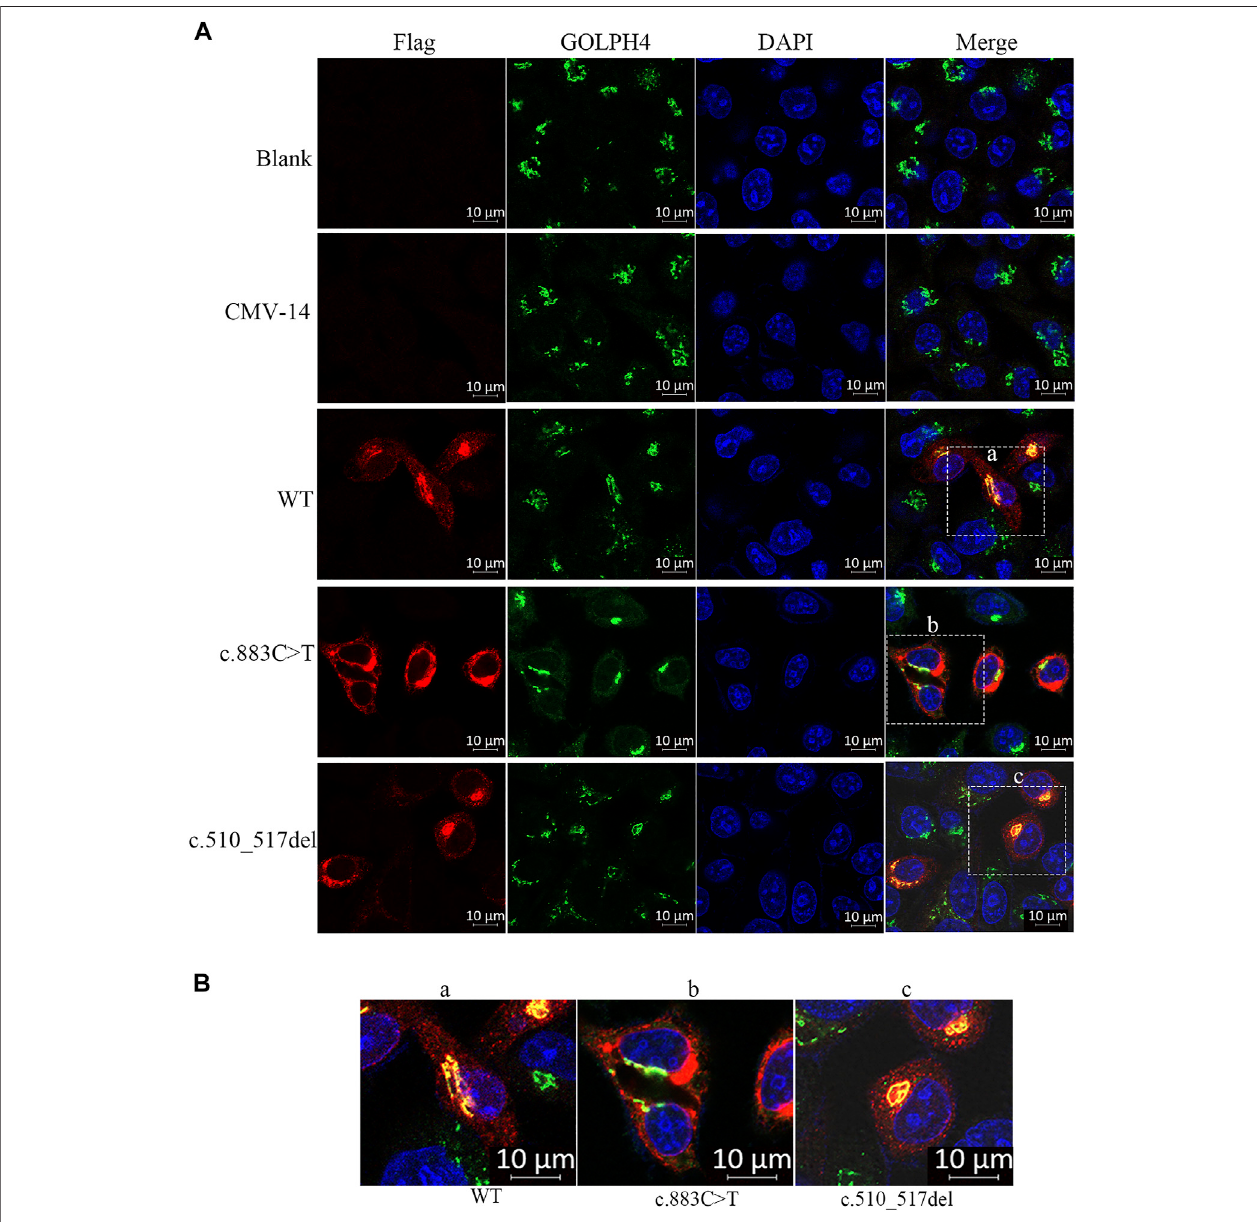
FIGURE 3 | Subcellular localization of β 3Galt6. (A) HeLa cells were transfected with plasmid carrying the wild-type (WT), the c.883C > T, or the c.510_517del variant. Cells were stained with anti-FLAG (red), anti-GOLPH4 (green), and DAPI (blue). (B) Enlarged images of (a – c) point of (A) .